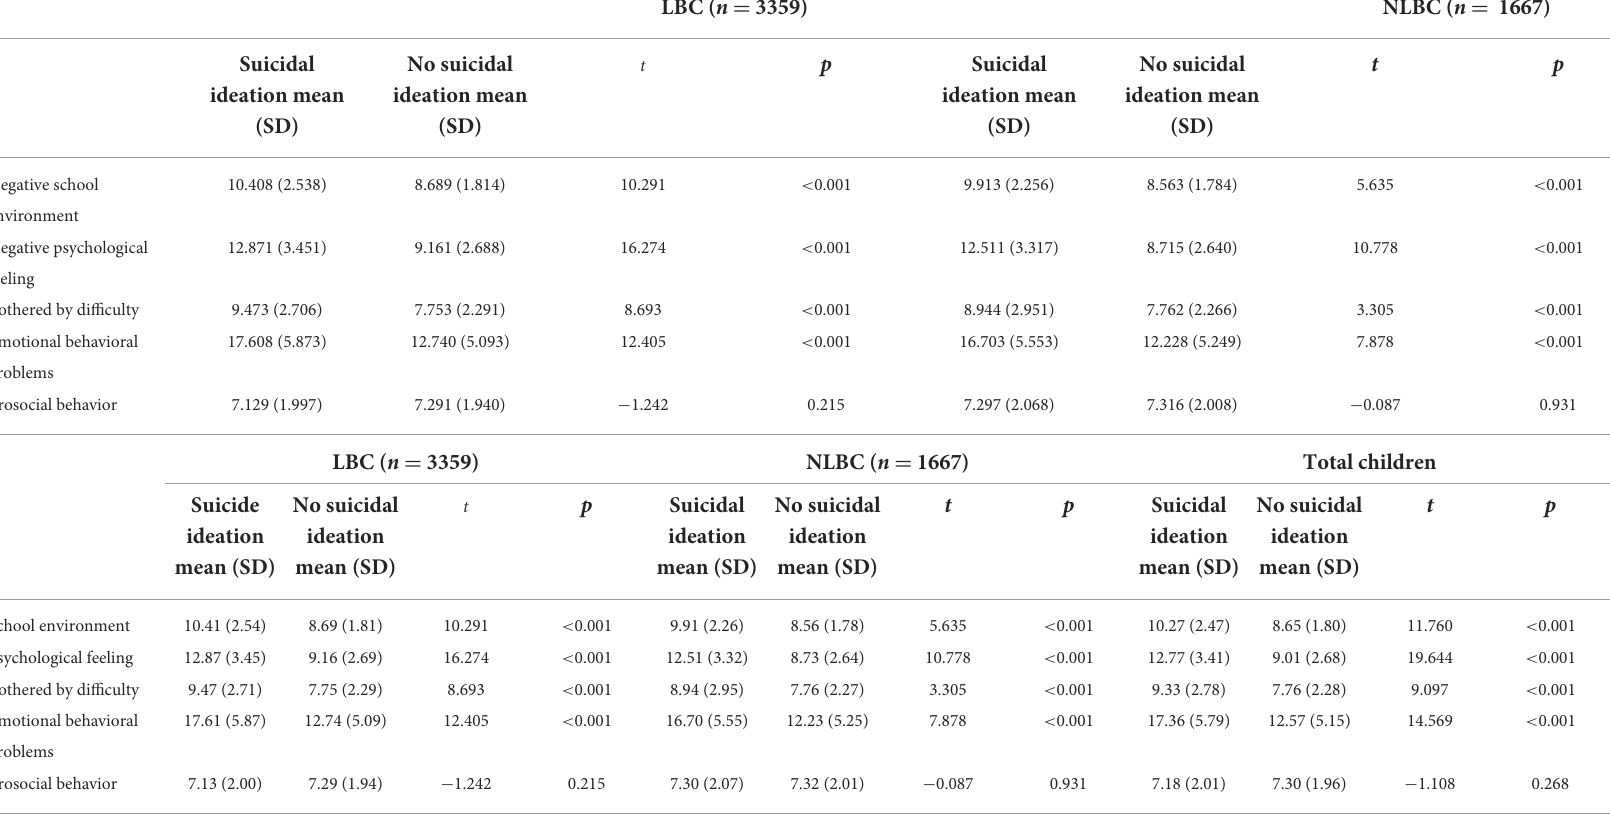
TABLE 4 Comparison of school environment, psychological feeling, total difficulties, prosocial behavior of LBC and NLBC by